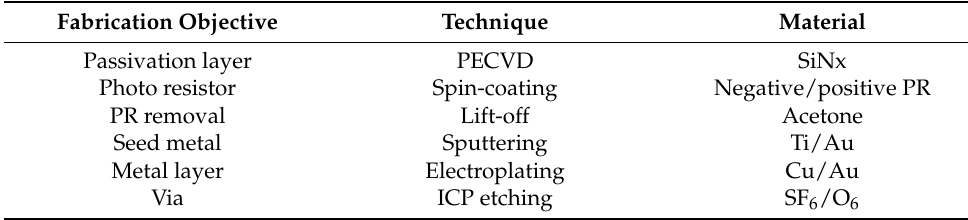
Figure 7. Fabrication of the proposed GaAs-based integrated passive device (IPD). Table 3. Manufacturing techniques used in the IPDs process. Table 3. Manufacturing techniques used in the IPDs